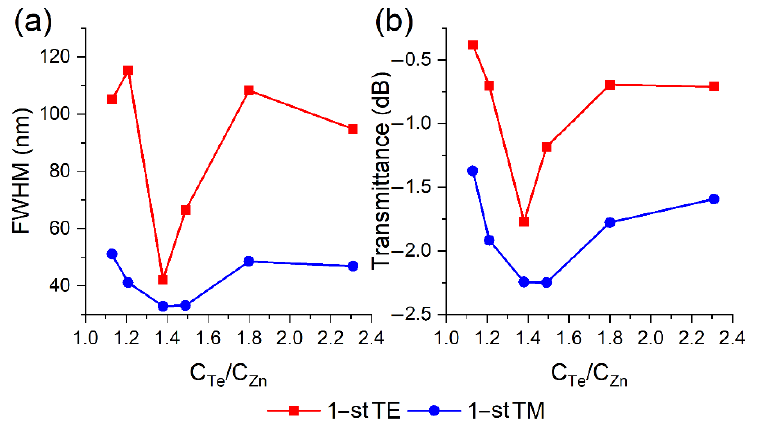
Figure 5. Dependence of ( a ) FWHM and ( b ) peak transmission on the C Te /C Zn ratio for the first TE and TM resonances with a maximum at a wavelength of 1450 nm.